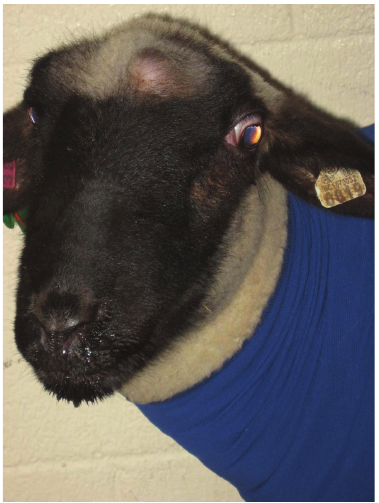
Figure 1: Picture of ewe on initial presentation with left-sided dorsal nasal mass.